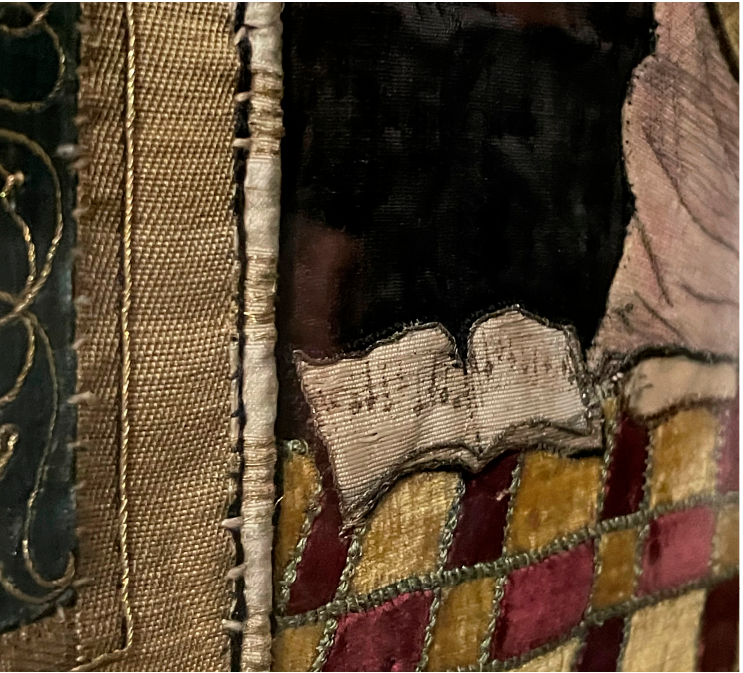
Figure 7. Detail of the ’MVSIQVES’ furnishing panel, showing the musical notation (photograph author’s